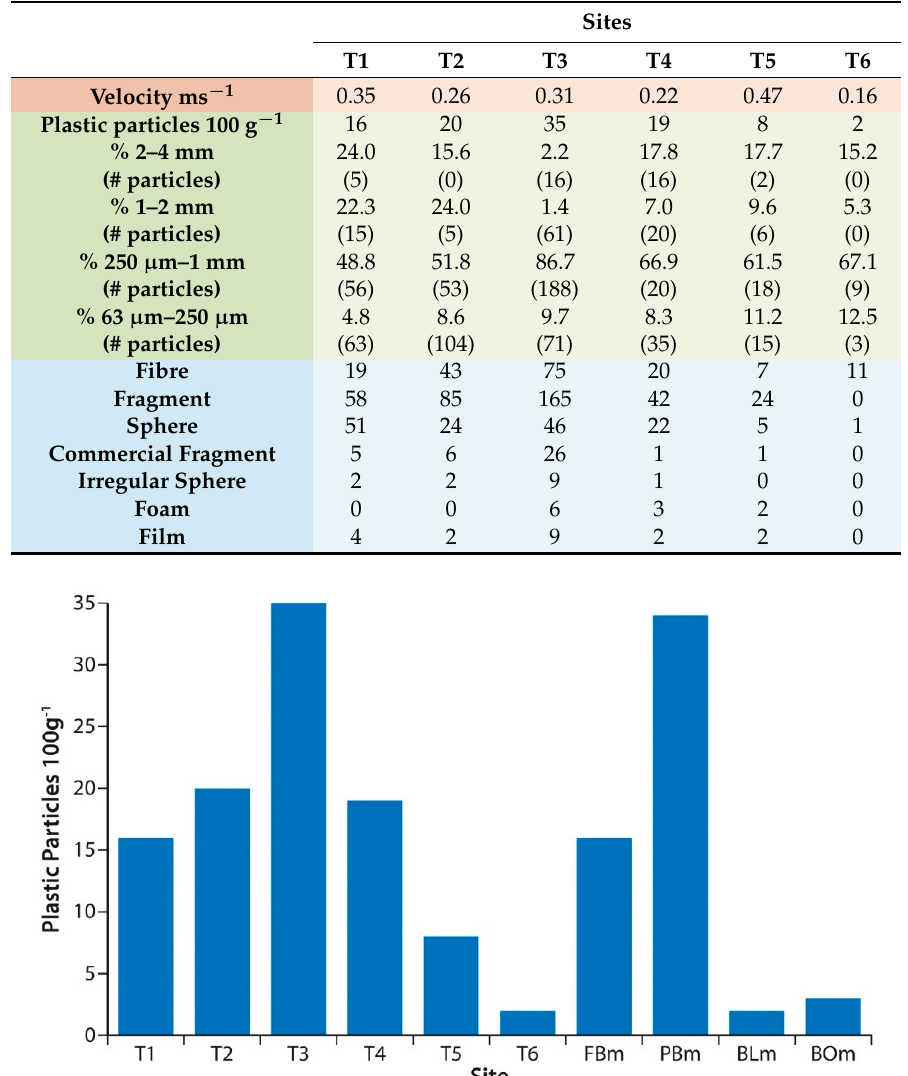
Table 1. Plastic particle abundance, proportion of sediment within each size fraction (# = number of plastic particles within each size fraction), flow velocity at time of sample collection and number of plastic particles within each shape class for the six sample sites along the main River Tame. T1–T3 are more urban sites and T4–T6 predominantly rural; a lake is present between sites T4 and T5. See Figure 1 for the location of each sample site.